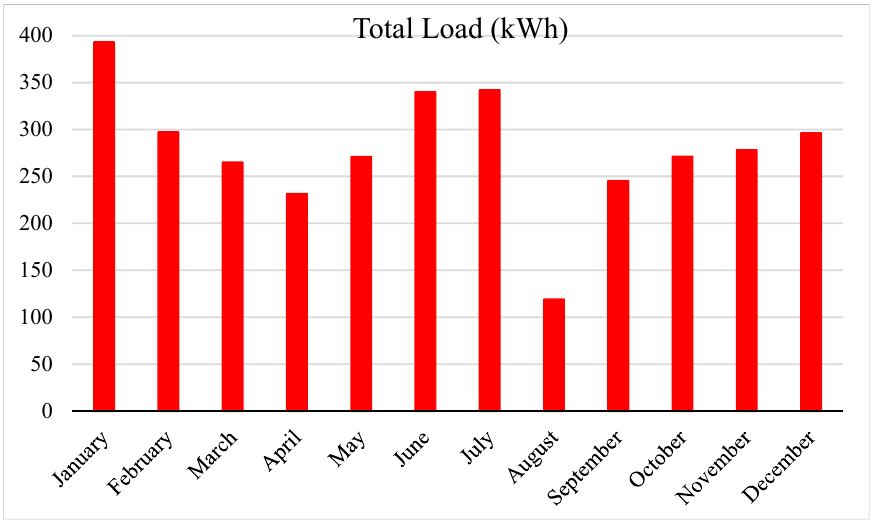
Figure 13. Total load demand per month in 2019 in kWh. 281